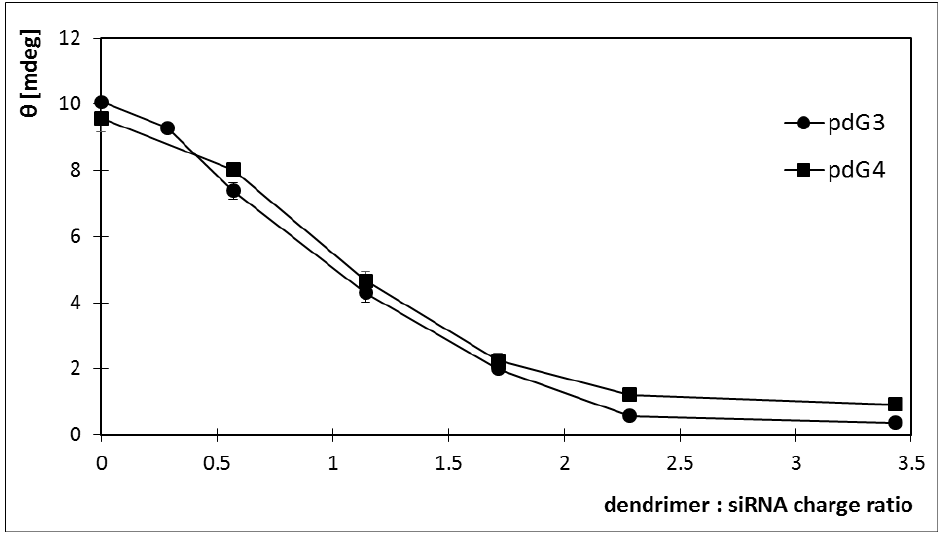
Figure 9. Changes in the ellipticity of dendriplexes formed by siRNA